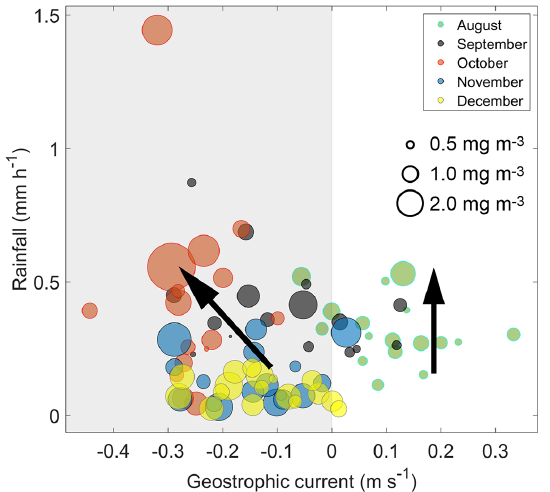
Figure 13. Bubble diagram showing the relationships between the geostrophic current and rainfall and the Chl a concentration. The size of the bubble represents the Chl a concentration. The left panel in gray represents the southwestern along-shelf current in winter. The right panel represents the northeastern along-shelf cur- rent in summer. Black arrows represent the relationship between the geostrophic current and rainfall and the Chl a